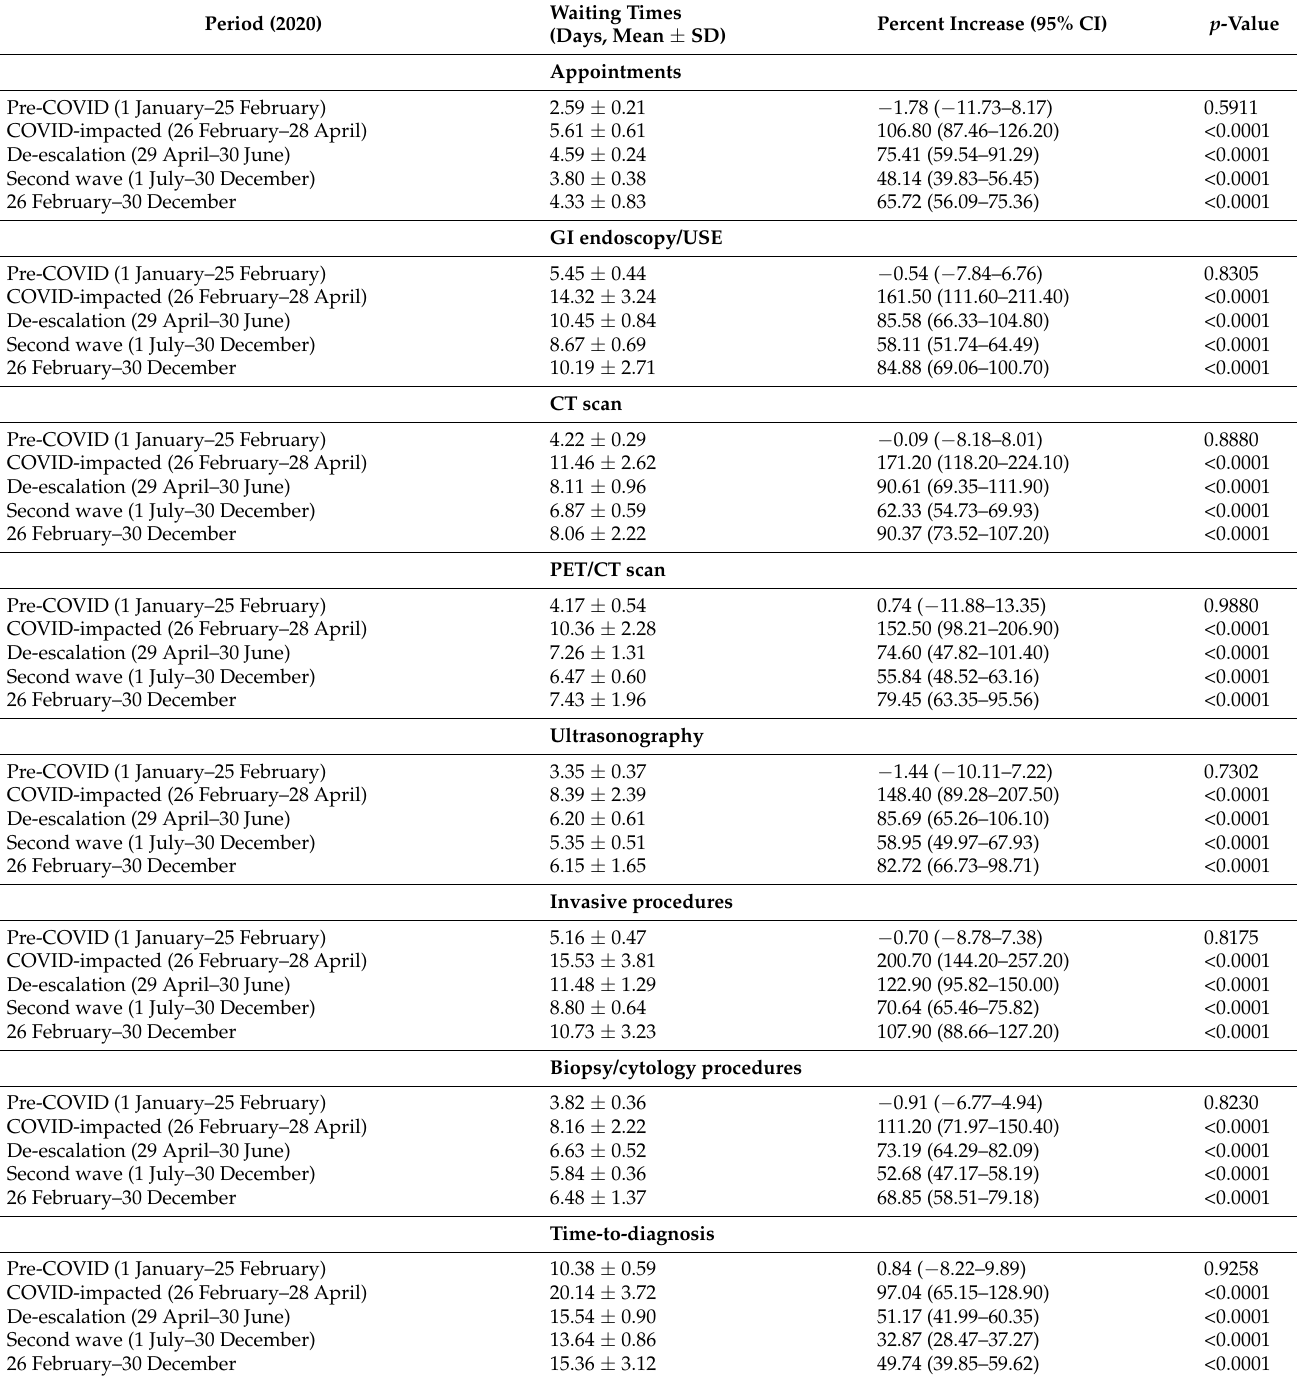
Table 3. Waiting times across study periods in 2020 and percent differences compared with